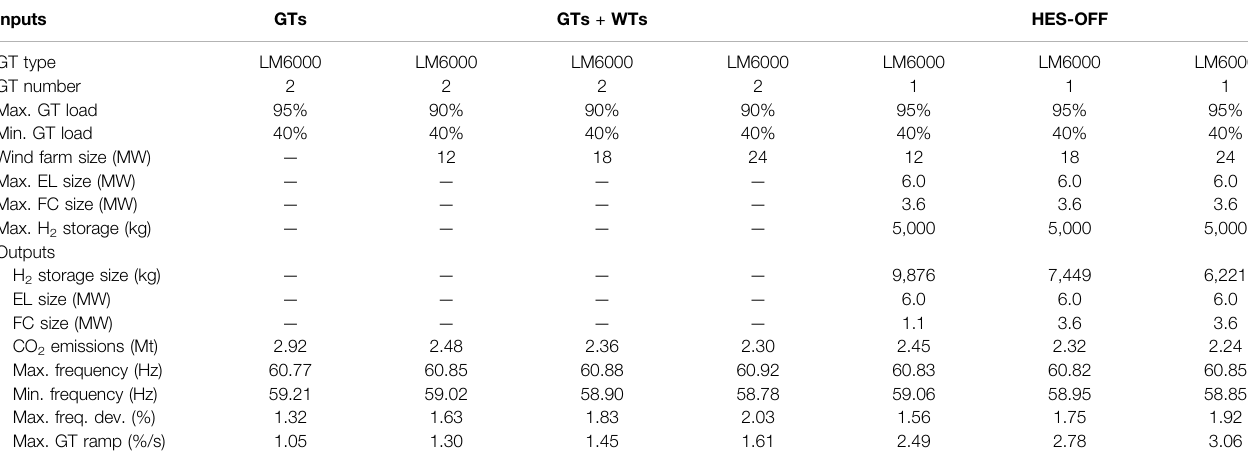
TABLE3| DesignsbasedontheLM6000GT-ComparativeanalysisbetweenastandardconceptonGTsonly(GTs),aconceptinvolvingGTsandWTs(GTs+WTs),andthe proposed concept (HES-OFF). Inputs GTs GT